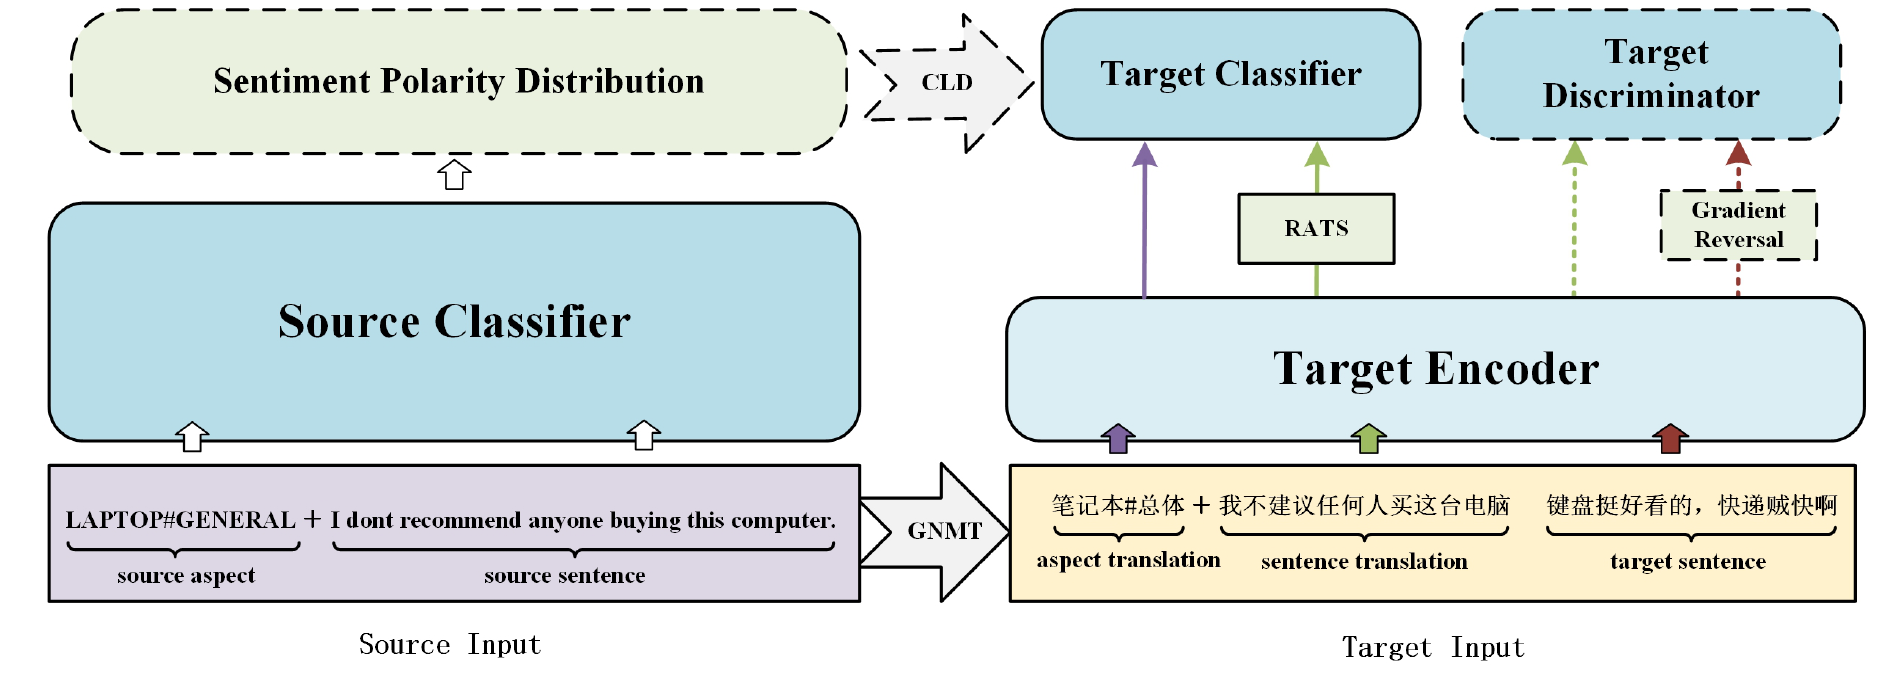
Figure 1. The overall framework of our approach. Note that we kept the parameter of source classifier constant in the training phase and the modules with dashed lines were not involved in the test